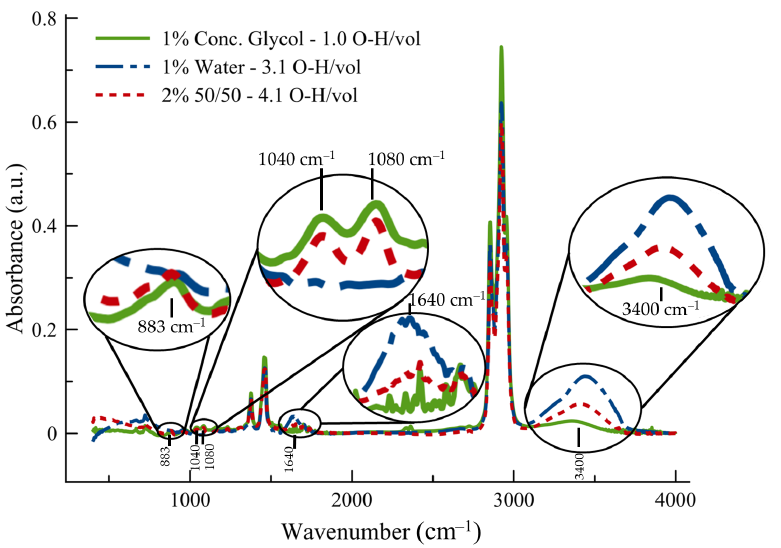
Figure 1. Typical FT-IR absorbance spectra of oil and contaminant with enlarged insets of the peaks of interest for water, glycol, and glycol/water contamination in engine oil. Note that 2% of the 50/50 mixture of glycol and water has more O–H bonds per unit volume than the other contaminants. The O–H bonds per unit volume were normalized to glycol. When plotting the maximum amplitudes for water, concentrated glycol, and the 50/50 mixture contaminants, the matrix effect is realized throughout the different con- centrations, as seen in Figure 2. Here, it is noted that points on the trendline for the volume of water have a greater maximum amplitude than that of double the volume of the 50/50 antifreeze despite having an equivalent amount of water.